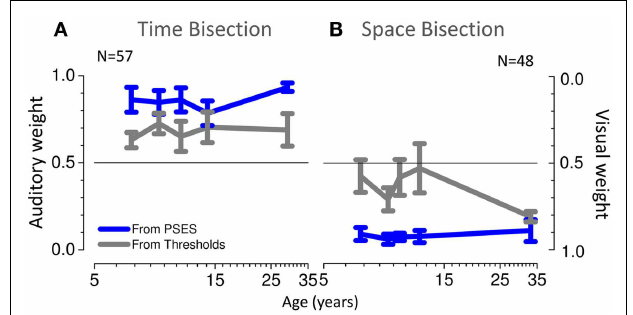
FIGURE 7 | (A) Average weights as a function of age, predicted from thresholds in gray and from PSEs in blue, for the time bisection task. (B) Same for the space bisection task.